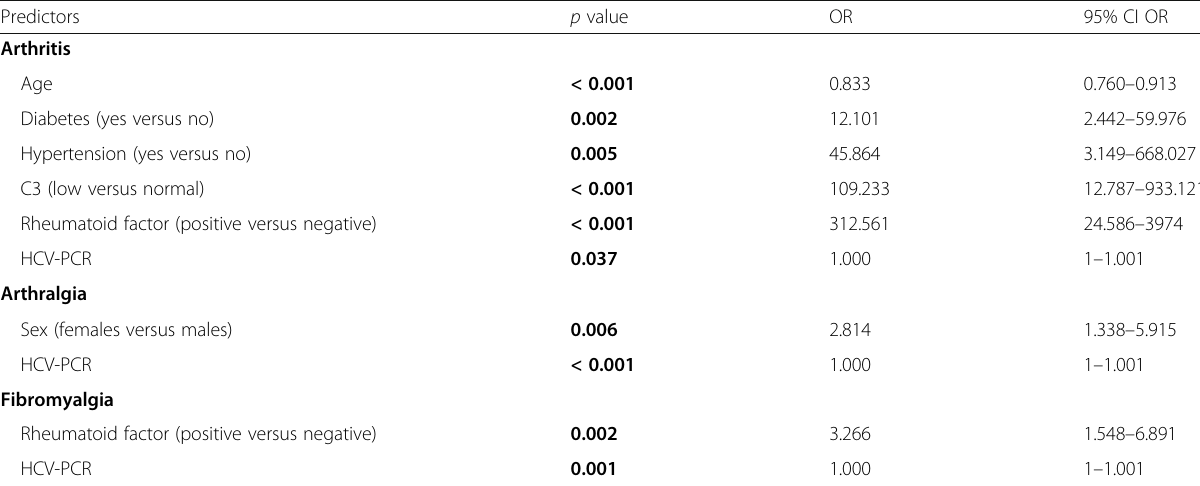
Table 4 Predictors for disease progression of the most common manifestations among HCV patients (forward step wise regression analysis)